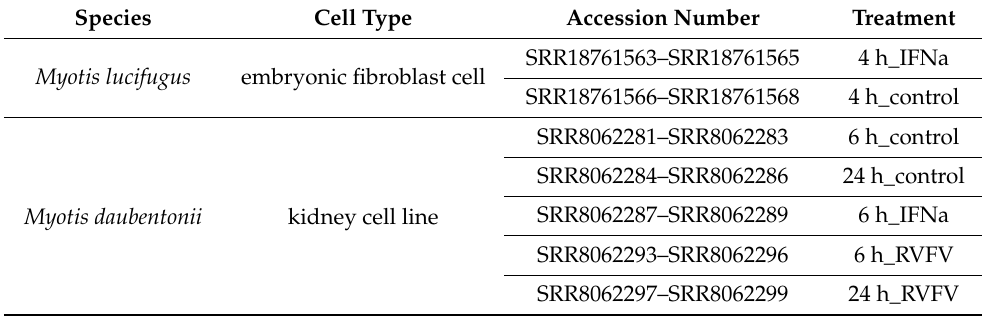
Table 3. Transcriptomic data used for expression analysis of bat TRIM